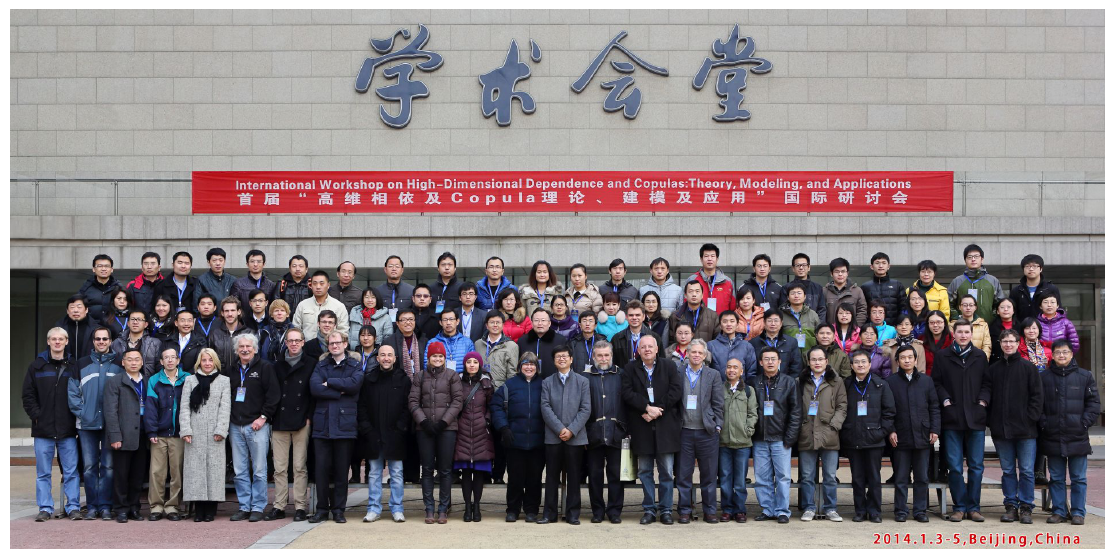
Figure 1: 2014 International Workshop on High-Dimensional Dependence and Copulas: Theory, Modeling, and